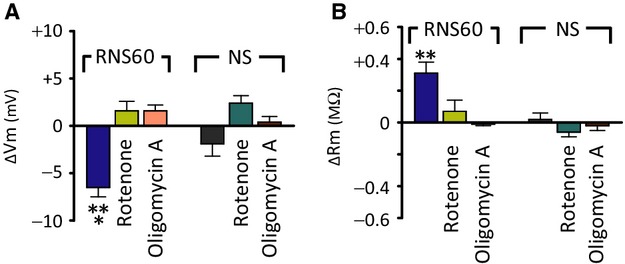
Effects of RNS60 on membrane potential (A) and membrane input resistance (B) following block of intracellular “usable ATP” inhibition. Note that RNS60 effect is absent after both the inhibition of electron transport chain in mitochondria by rotenone and after oligomycin A, an inhibitor of ATP synthase. **P < 0.01 and ***P < 0.001 by paired t-test, indicating that the target for RNS60 action is mitochondrial ATP synthesis (n = 7 in RNS60 with rotenone, 6 in RNS60 with oligomycin A, 8 in NS with rotenone, and 6 in NS with oligomycin A).